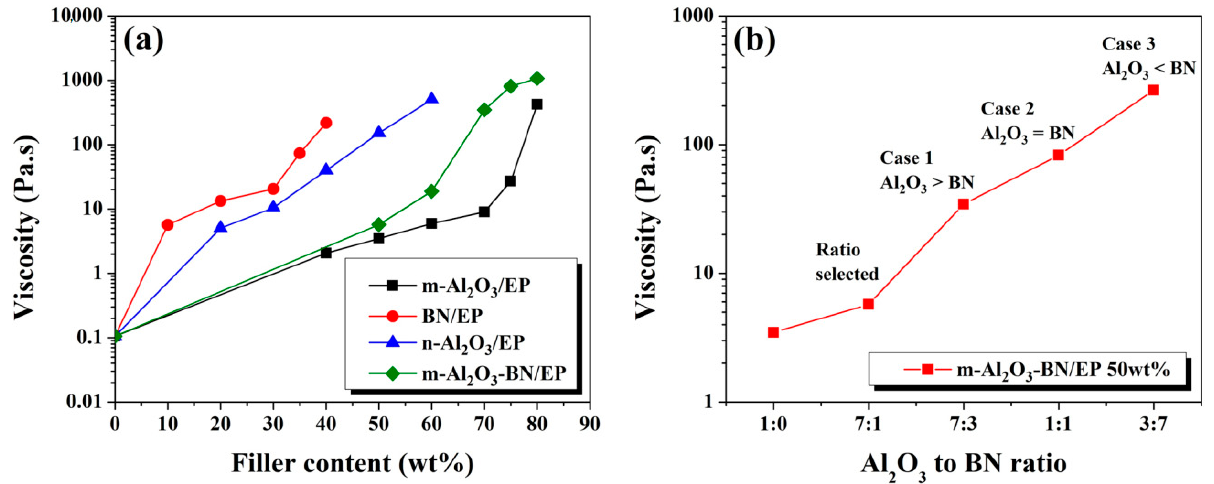
Figure 5. Viscosity charts of ( a ) the distinct EP composites as a function of filler content and ( b ) m-Al 2 O 3 -BN/EP with 50 wt% as a function of Al 2 O 3 to BN ratio.